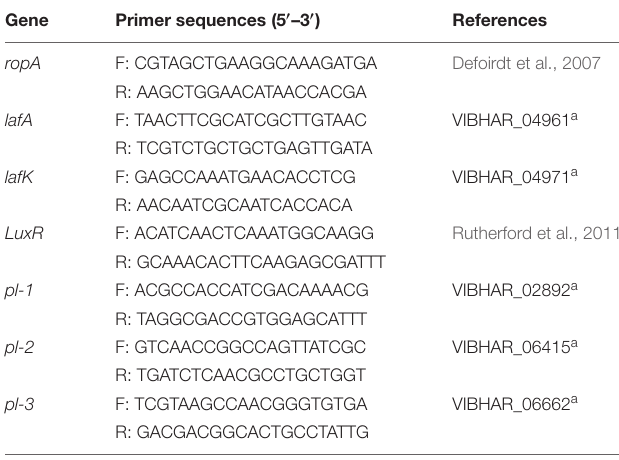
TABLE 1 | Specific primers used for reverse transcriptase real-time